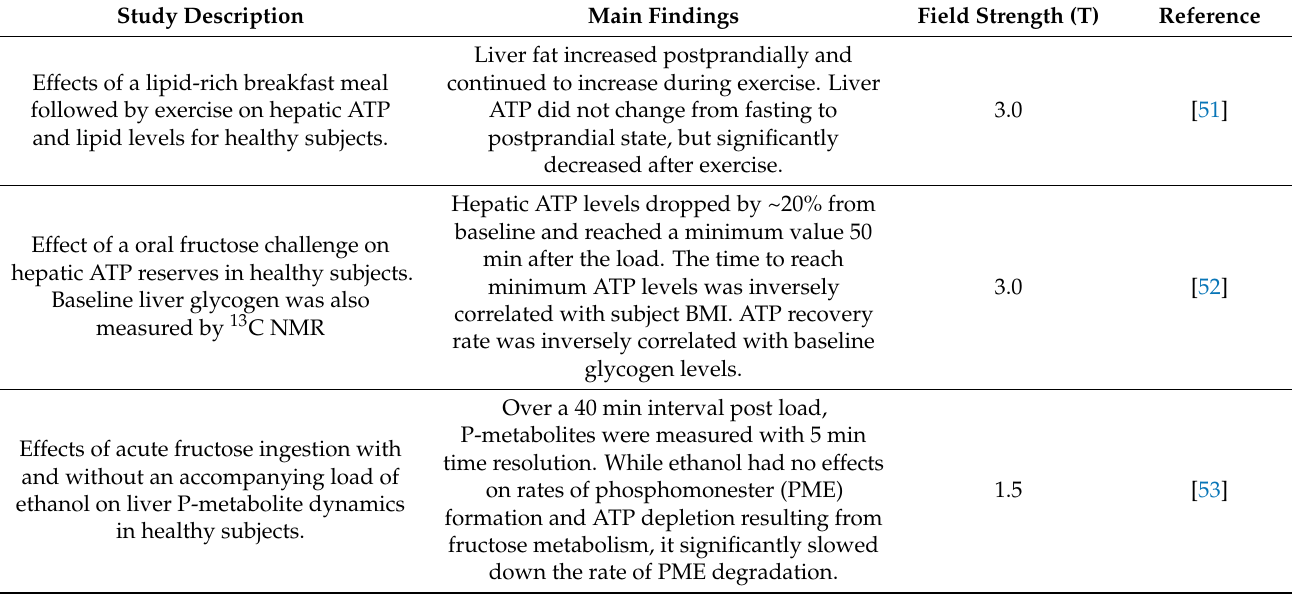
Figure 1. Comparison of in vivo 31 P MR spectra of human liver acquired at 3 T ( top ) and at 7 T ( bottom ). This figure was adapted from ref. [39]. Table 1. Selected in vivo 31 P MRS studies of liver metabolism in human